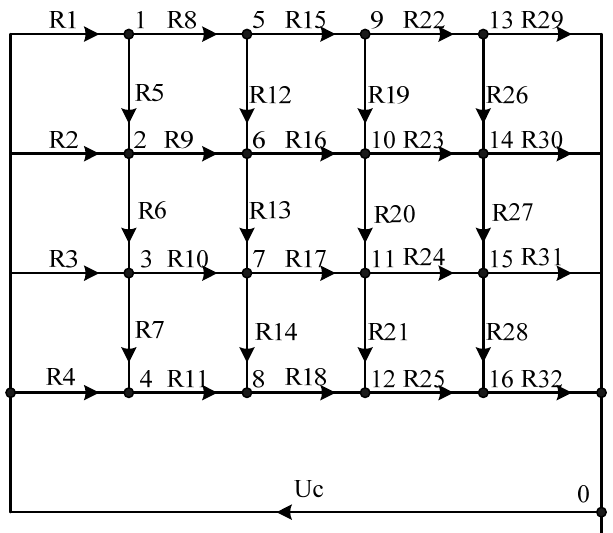
Figure 3. Oriented graph of a circuit model.